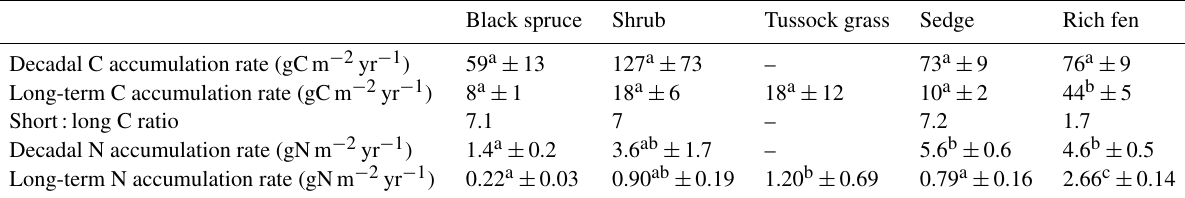
Table 3. Decadal (<60 years) and long-term (780–1400 years) C and N accumulation rates (gm − 2 yr − 1 ) with their standard deviations. Accumulation rates were determined by averaging values calculated for each individual soil profile by ecosystem type. Different letters indicate significant differences among ecosystems for that accumulation rate, based on Tukey Honest Significant Difference test. Black spruce